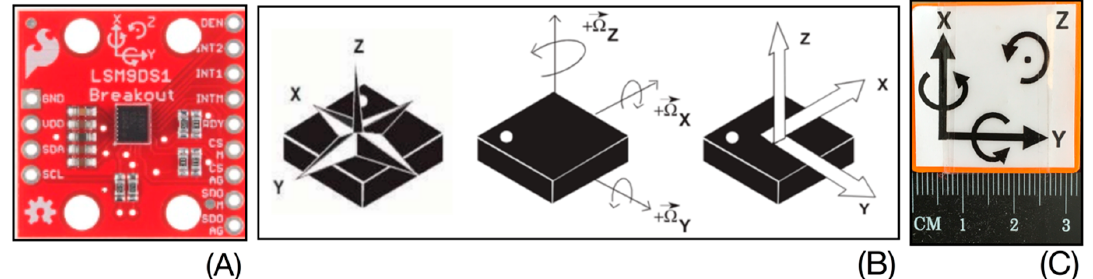
Figure 3. ( A ) Micro Electro-Mechanical Systems (MEMS). ( B ) 3-axis accelerometer, a 3-axis gyrometer, a 3-axis magnetometer and a temperature sensor. ( C ) Dimension of the DYSKIMOT.